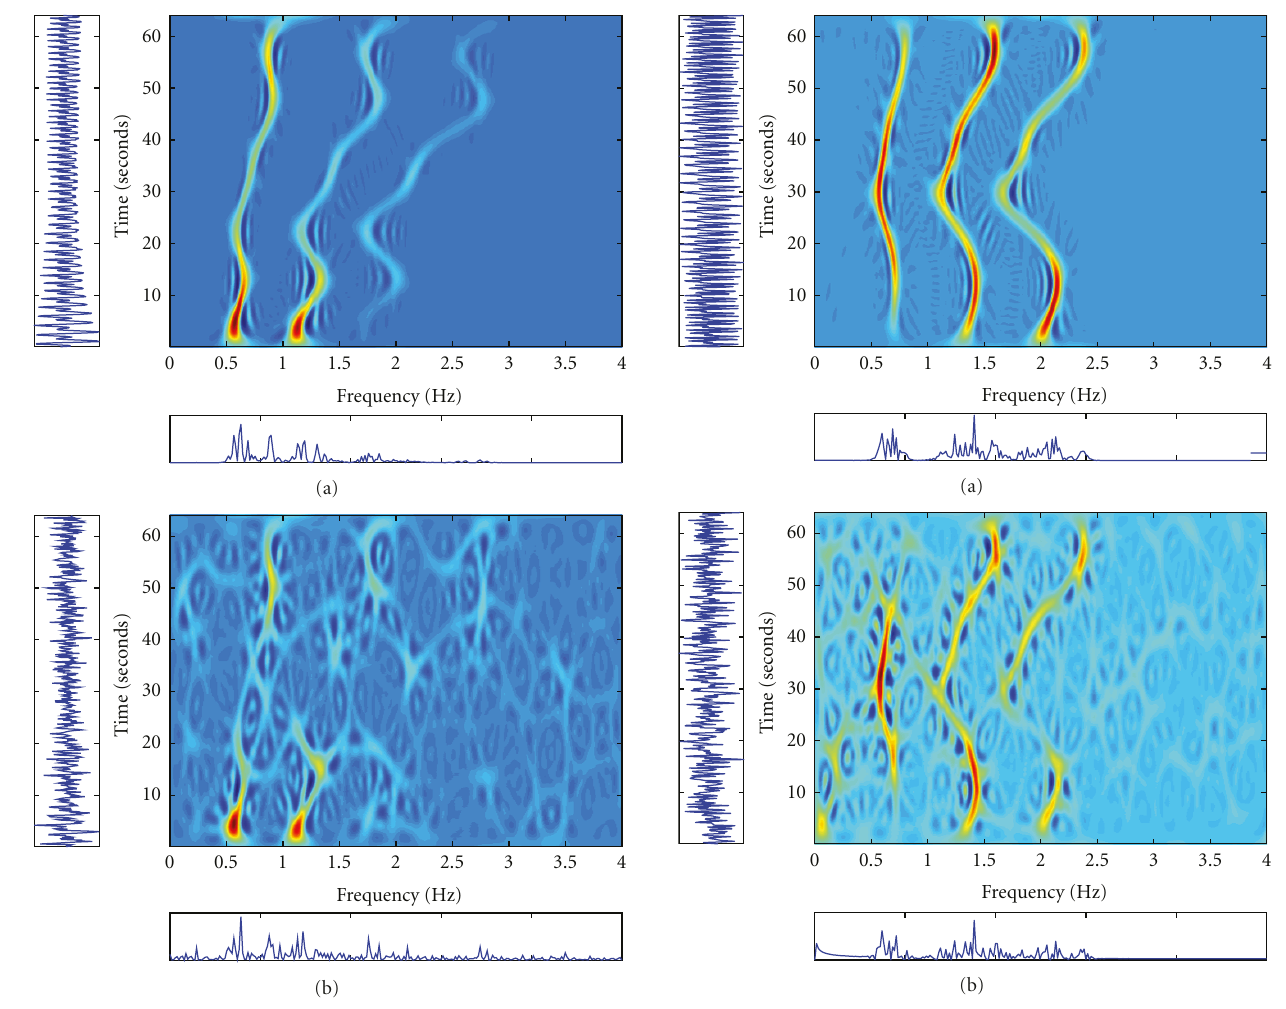
Figure 3: Simulated signal with low-energy harmonics: (a) SNR of 20dB, and (b) SNR of 0dB. Noise is white Gaussian noise.